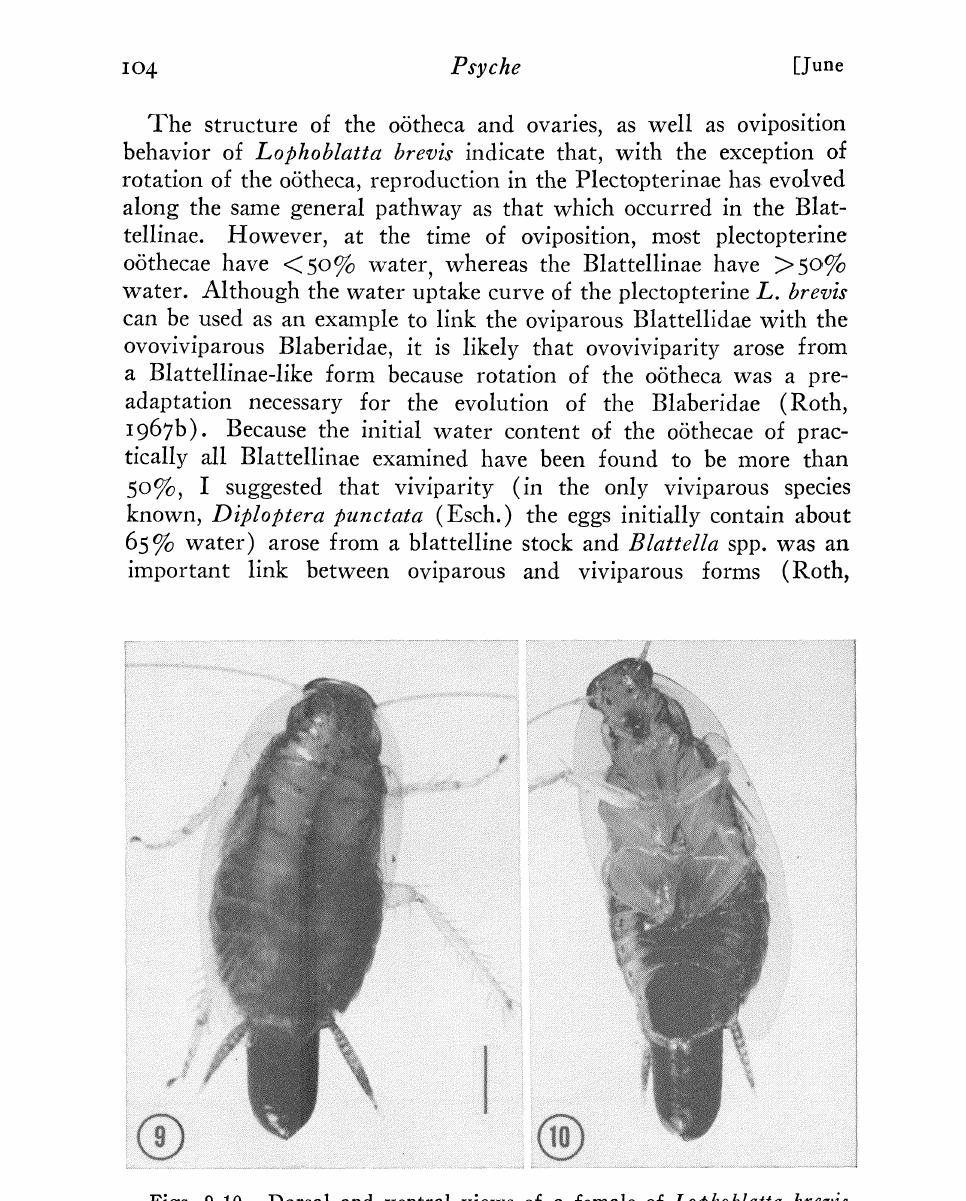
Figs. 9-10. Dorsal and ventral views of a female of LoIhoblatta breeis, carrying an o6theea (line 2